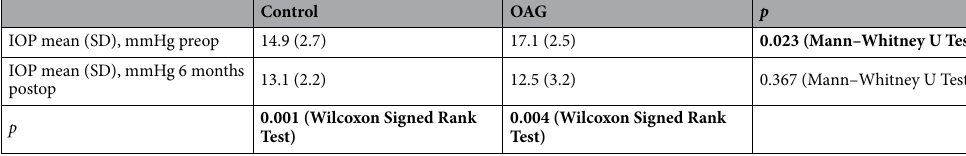
Table 2. IOP pre- and postoperatively (Significance in bold). The preoperative IOP was higher in OAG group. The postoperative IOP was similar between the groups. IOP decreased significantly in both groups after cataract